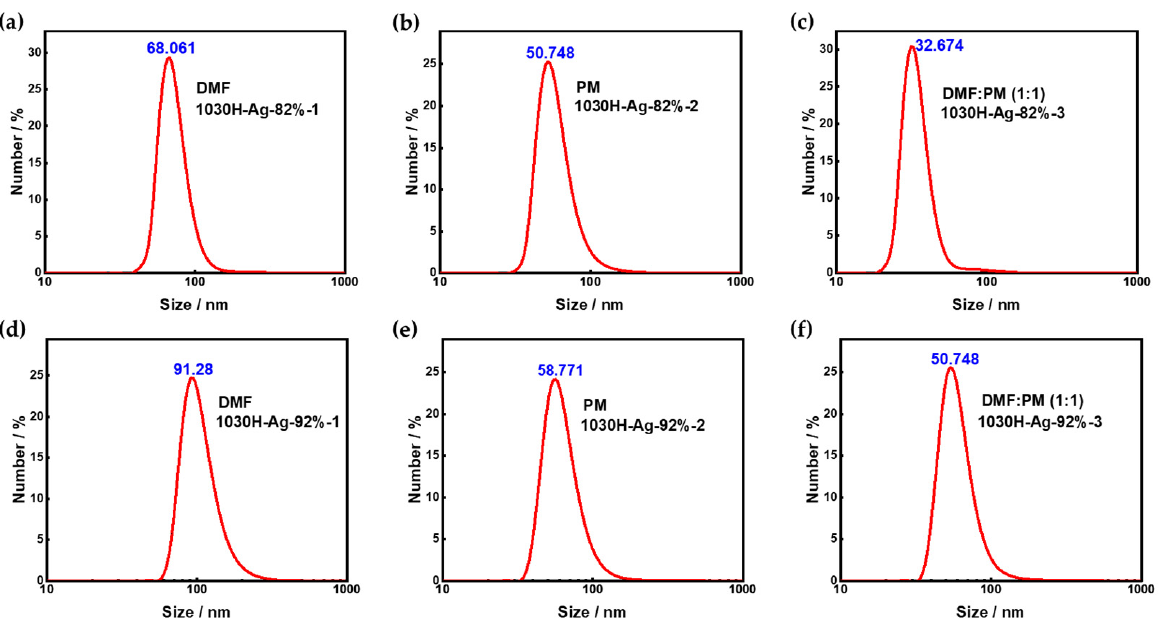
Figure 11. Particle size of silver conductive ink in different solvent systems. ( a ) 1030H-Ag-82%-1 conductive ink; ( b ) 1030H-Ag-82%-2 conductive ink; ( c ) 1030H-Ag-82%-3 conductive ink; ( d ) 1030H-Ag-92%-1 conductive ink; ( e ) 1030H-Ag-92%-2 conductive ink; ( f ) 1030H-Ag-92%-3 conduc- tive ink.